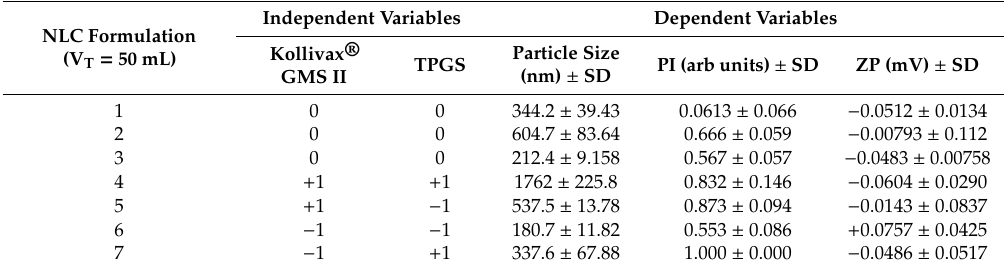
Table 7. 2 2 full factorial design for the development of sucupira-oil loaded NLC and respective response parameters.